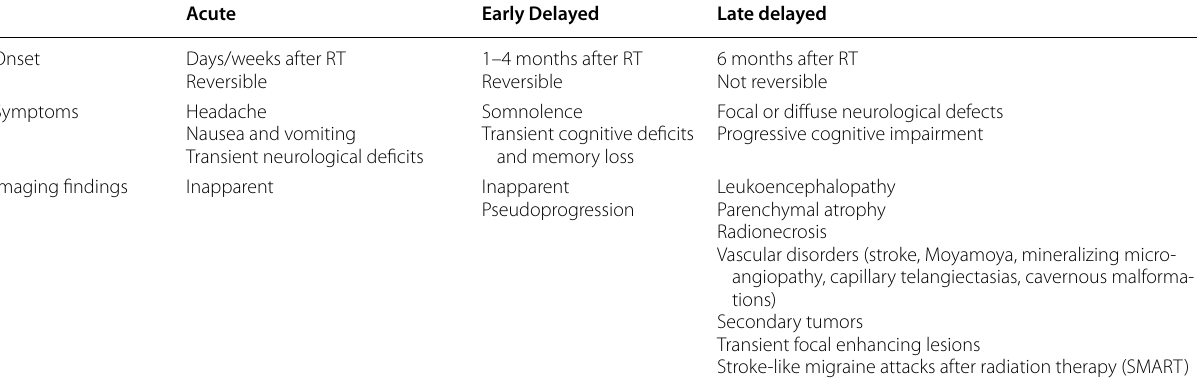
Table 1 Timeline, symptoms, and imaging findings of radiation-induced brain injury [11–14] Acute Early